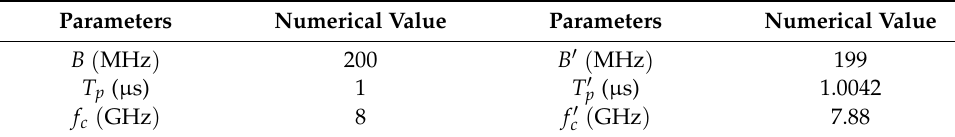
Table 7. Anti-jamming simulation parameters.